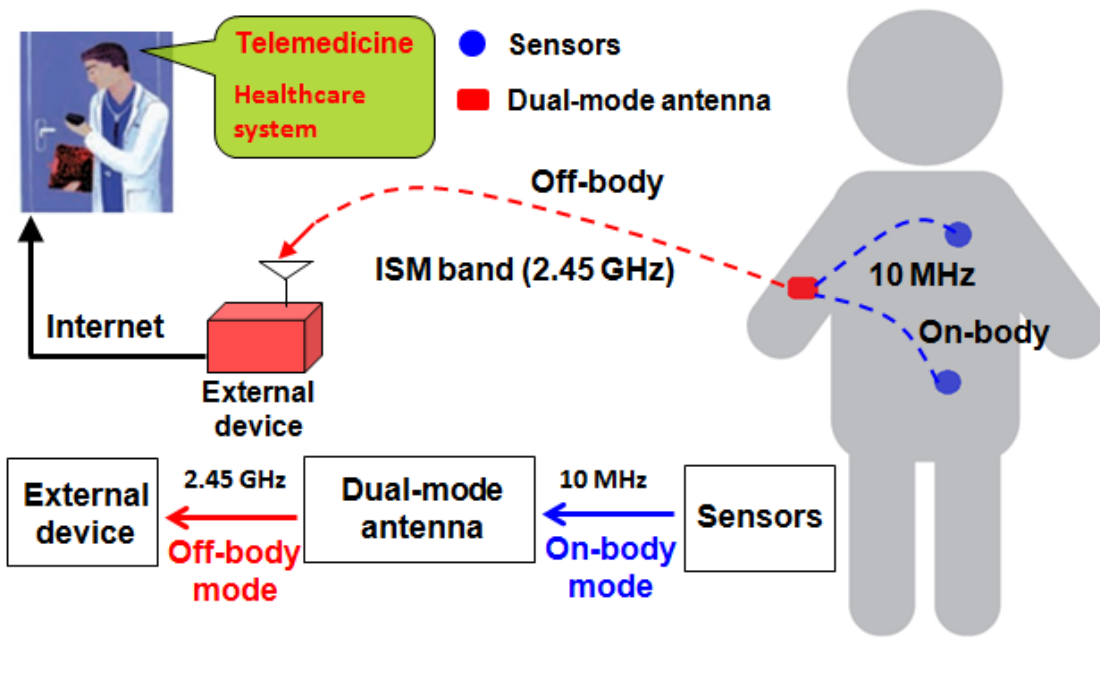
Figure 3. Proposed medical application